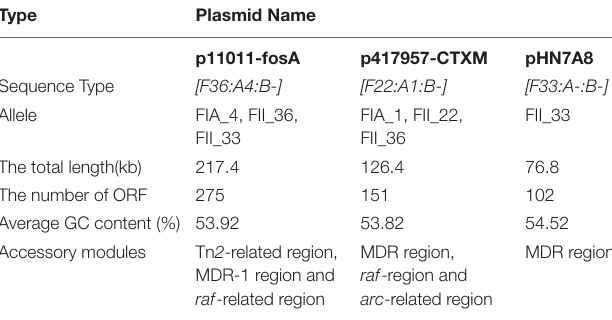
TABLE 3 | Major features of plasmids analyzed.